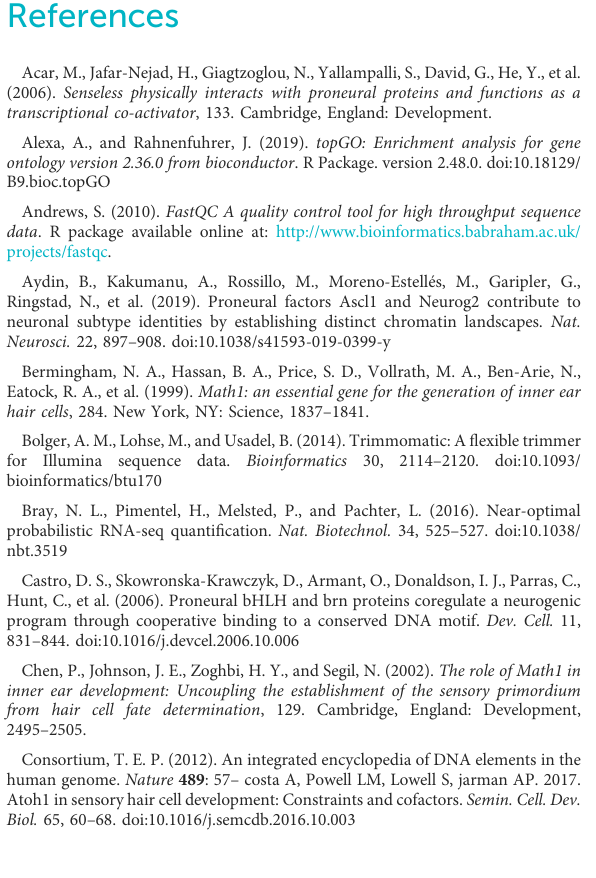
G fi 1 has both positive and negative effects on Atoh1-induced transcriptomes (A) Cluster analysis of gene expression in iG fi 1, iAtoh1, iG+A, and iGPA cells. Group 4 (Atoh1-dependent genes that are repressed by presence of G fi 1) is shown expanded to the right. (B) Examples of G fi 1 binding peaks at G fi 1-repressed